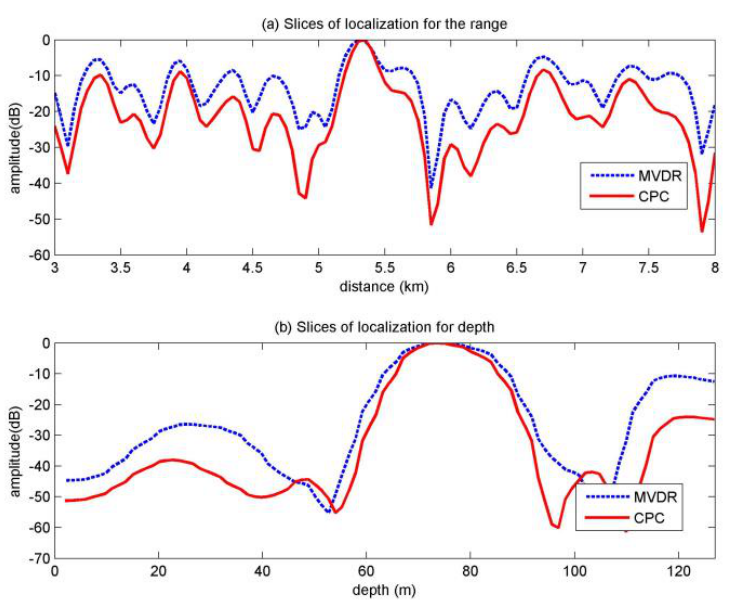
Figure 8. Slices of the moored source at the first minute.